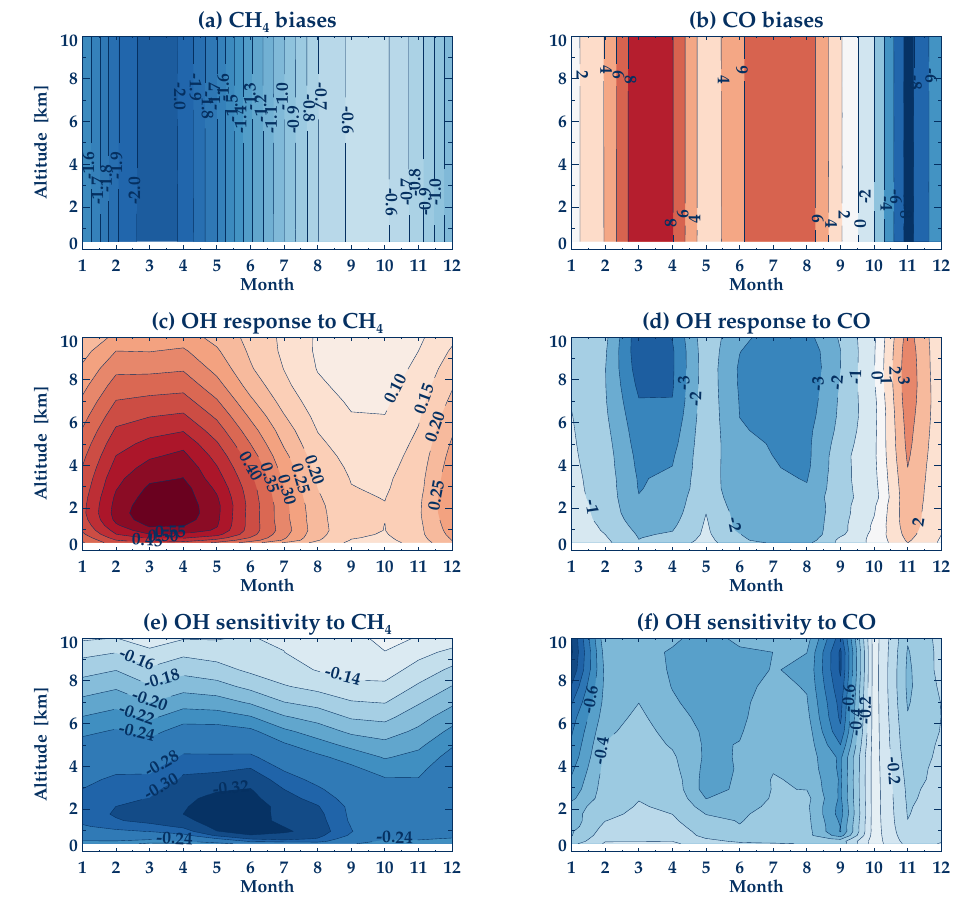
Figure 7. Multi-annual and monthly-mean OH responses to CH 4 and CO biases between observations and the reference simulation. (a) Dif- ference in CH 4 (%) relative to the reference simulation. (b) Difference in CO (%) relative to the reference simulation. (c) OH difference (%) relative to the reference simulation caused by the CH 4 change (a) . (d) OH difference (%) relative to the reference simulation caused by the CO change (b) . (d) Ratio of relative OH changes (c) to relative changes in CH 4 (a) . (f) Ratio of relative OH changes (d) to relative changes in CO (b)